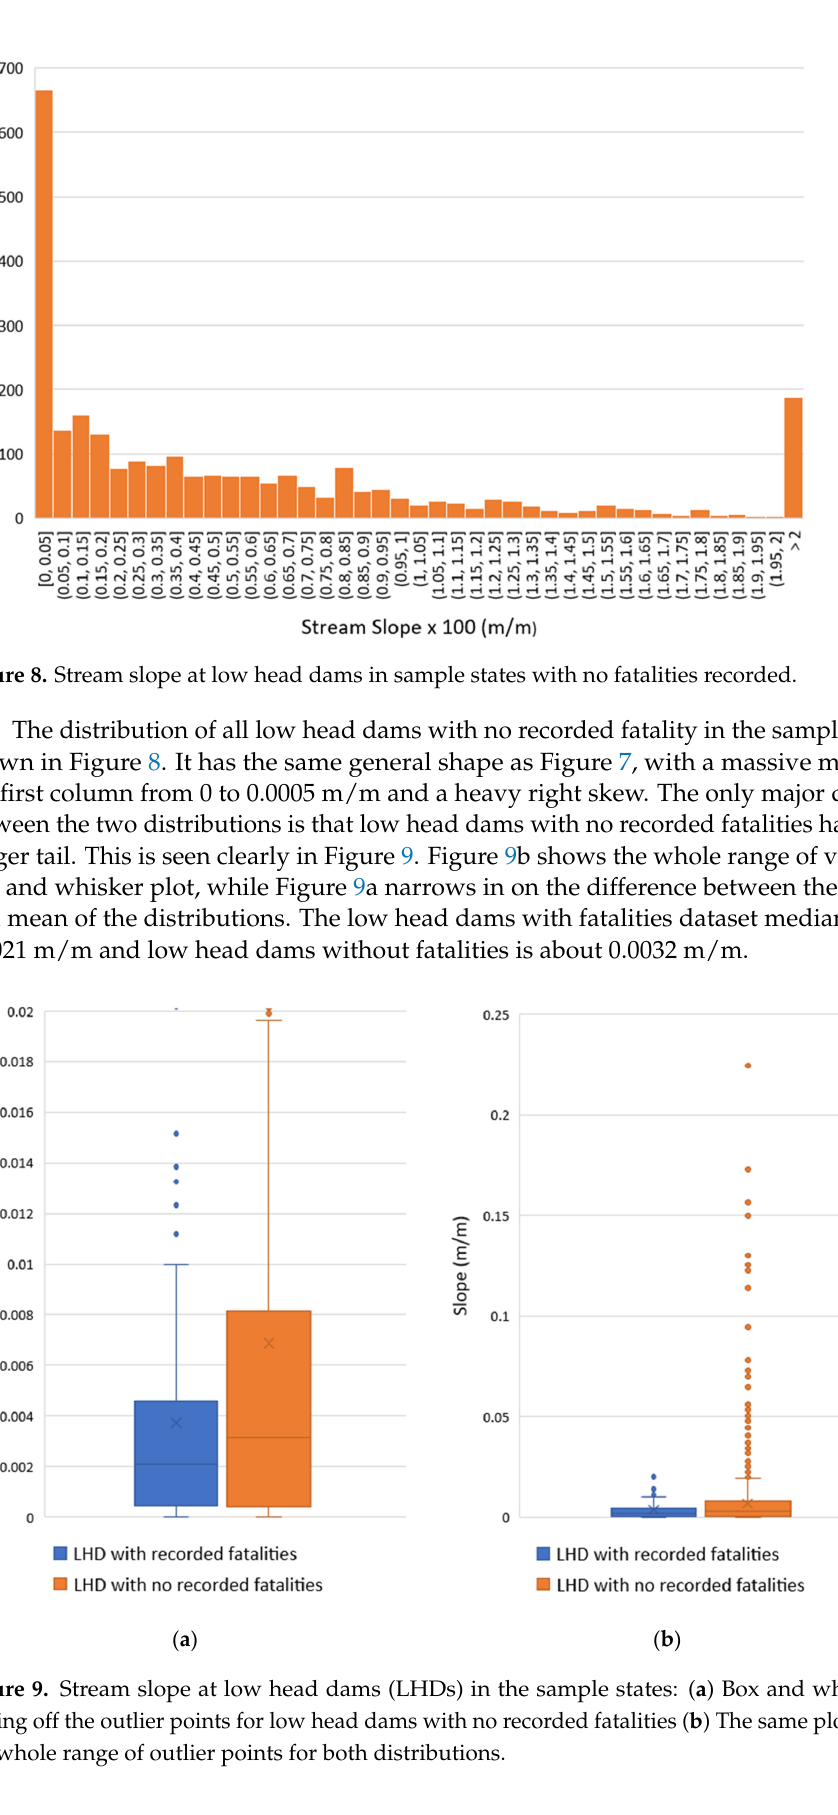
Figure 9. Stream slope at low head dams (LHDs) in the sample states: ( a ) Box and whisker plot cutting off the outlier points for low head dams with no recorded fatalities ( b ) The same plot showing the whole range of outlier points for both distributions.